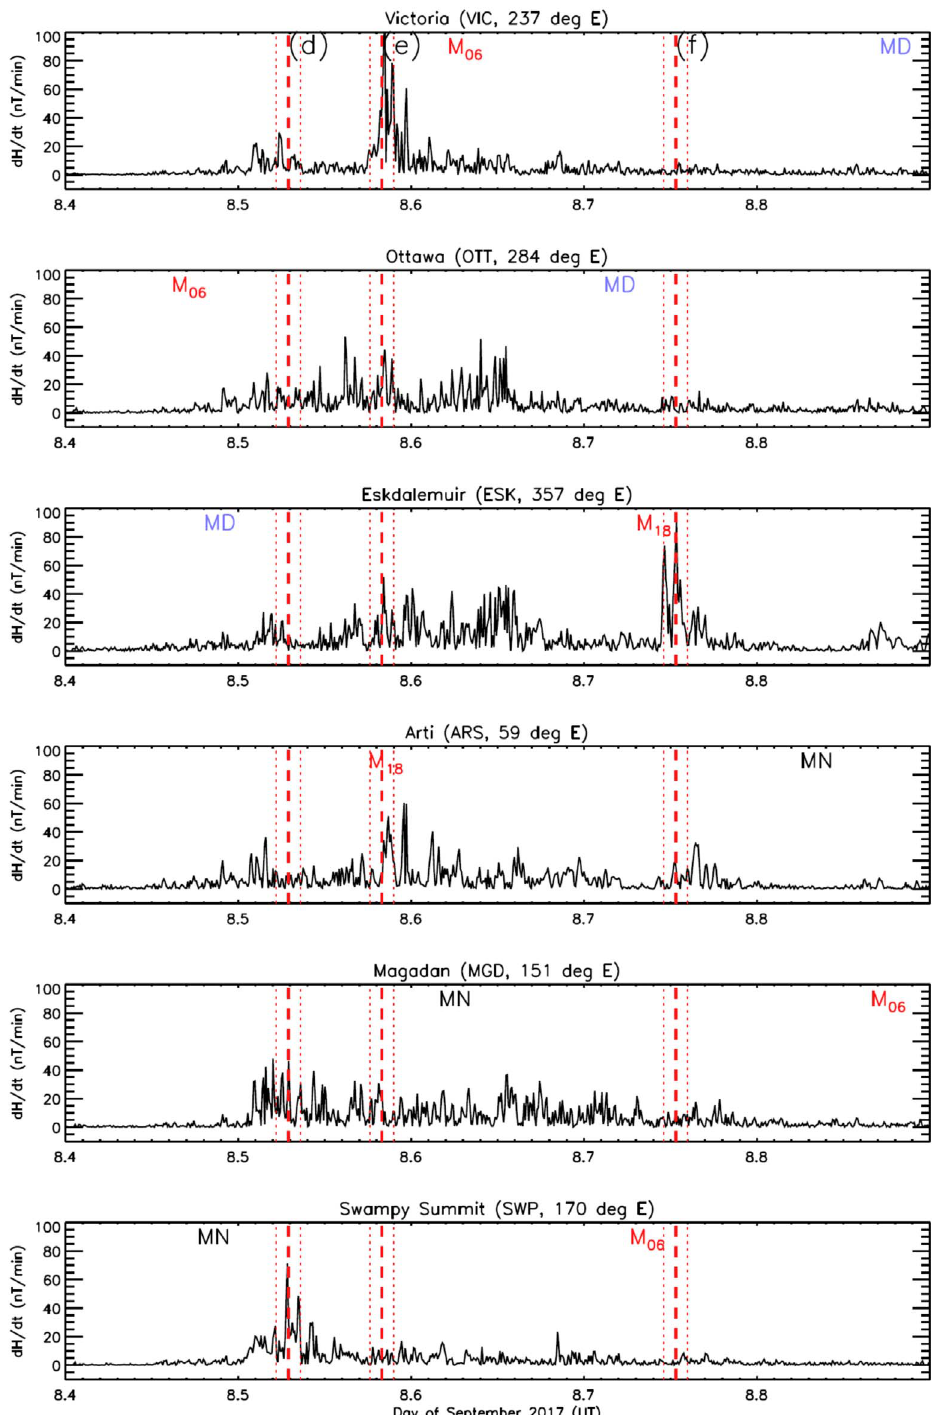
Fig. 4. As for Figure 3 but for Interval 2 (8 September 2017). Large d H /d t times are indicated by (d) –